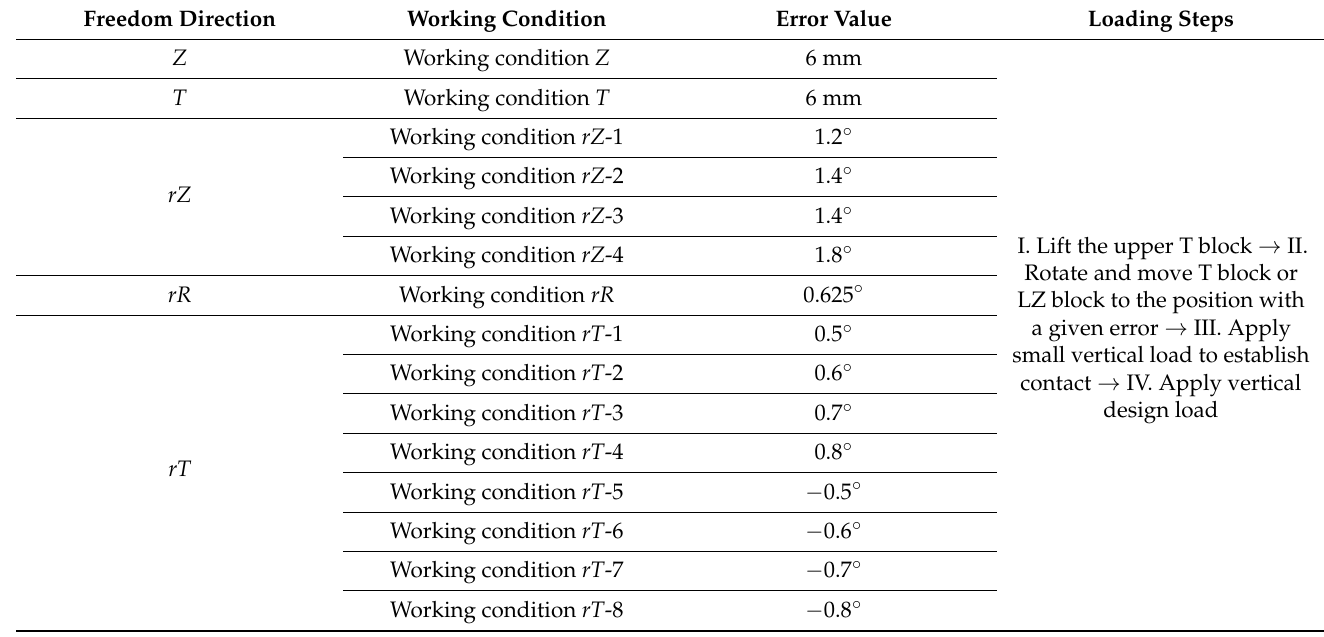
Table 4. Loading conditions of the DOF for different